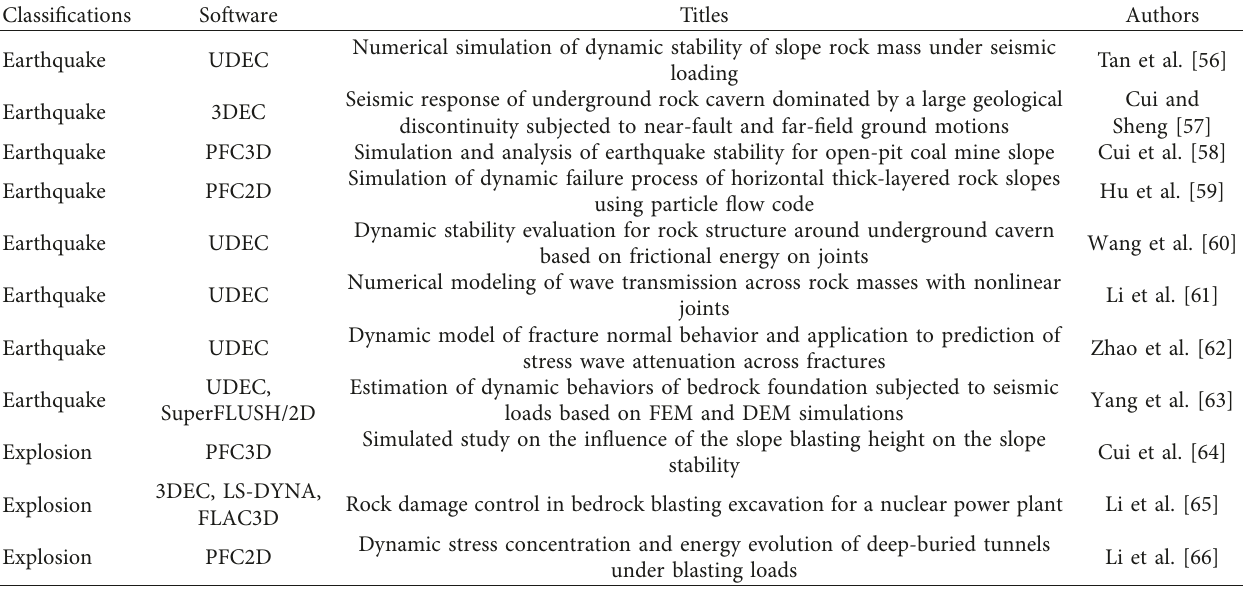
Table 2: Applications of the discrete element method in dynamic stability analysis of rockmass.